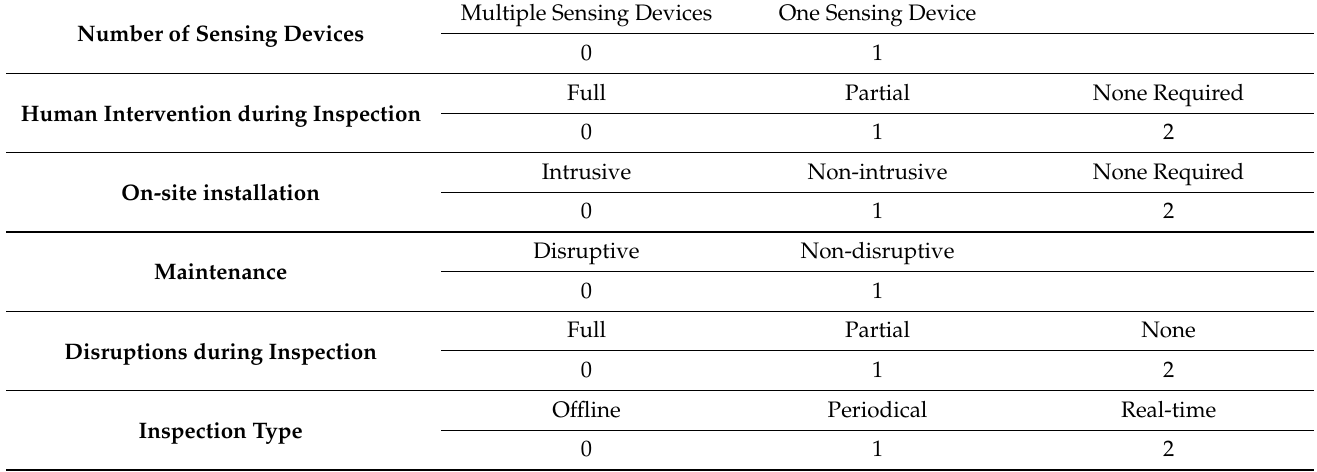
Table 2. Scoring matrix for